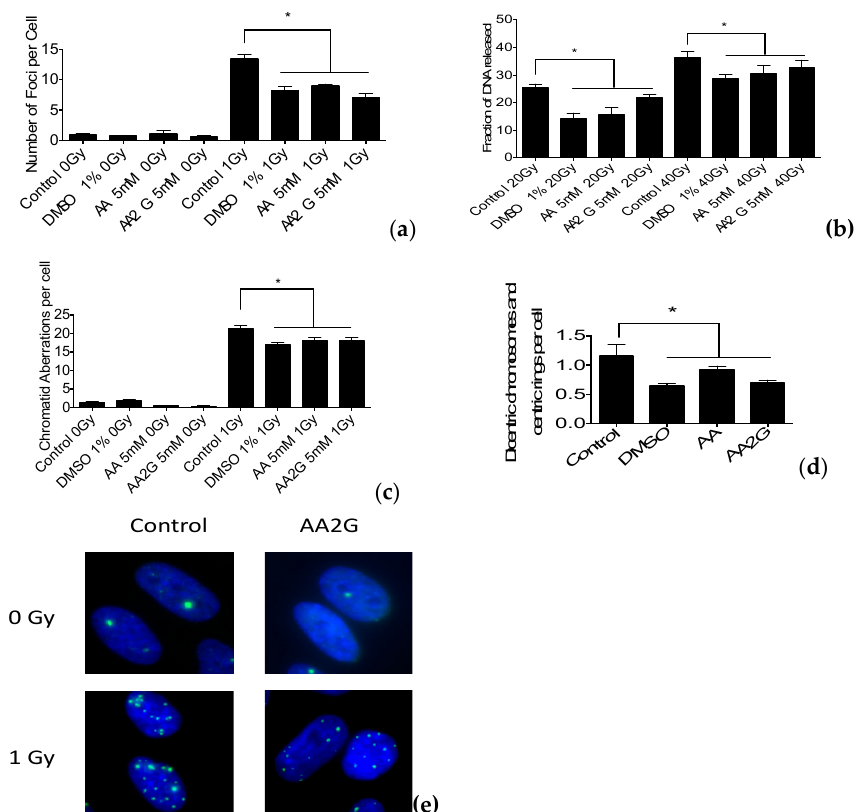
Figure 4. Effects of DMSO, AA, and AA2G for the radiation induced damages: ( a ) Changes in DNA double strand breaks measured by gamma-H2AX foci immunostaining assay at 30 min after irradiation with AG1522 cells; ( b ) Changes of initial DNA double strand breaks measured by constant field gel electrophoresis as a fraction of DNA released to gel with CHO10B2 cells; ( c ) Chromatin DNA damage measured by G2-premature chromosome condensation at 30 minutes after irradiation with A549 cells; ( d ) Chromosomal aberration analysis. Cells in G1 phase were irradiated with 4Gy and first post irradiation metaphase chromosomes were analyzed with CHO10B2. Error bars indicate standard error of the means of three independent experiments. * means statistically significant differences ( p < 0.05). ( e ) representative images of gamma-H2AX foci (green) and nuclear stain with DAPI (blue).